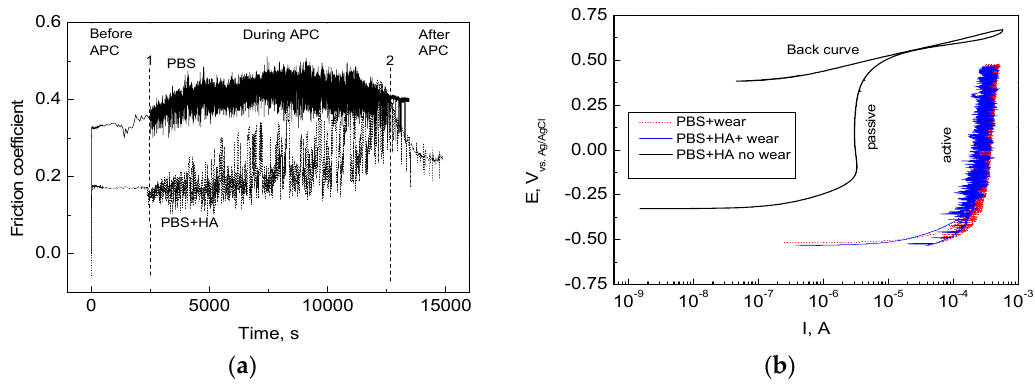
Figure 2. Friction coefficient of HCCoCr/alumina pair ( a ) and anodic polarization curves (APC) of HCCoCr disks ( b ) during wear corrosion tests in PBS and PBS containing 3 g/L HA (PBS-HA). Measurement of the friction coefficient before, during, and after application of anodic polarization current (APC). Anodic polarization curve for HCCoCr alloy in PBS-HA without wear is added for comparative analysis.